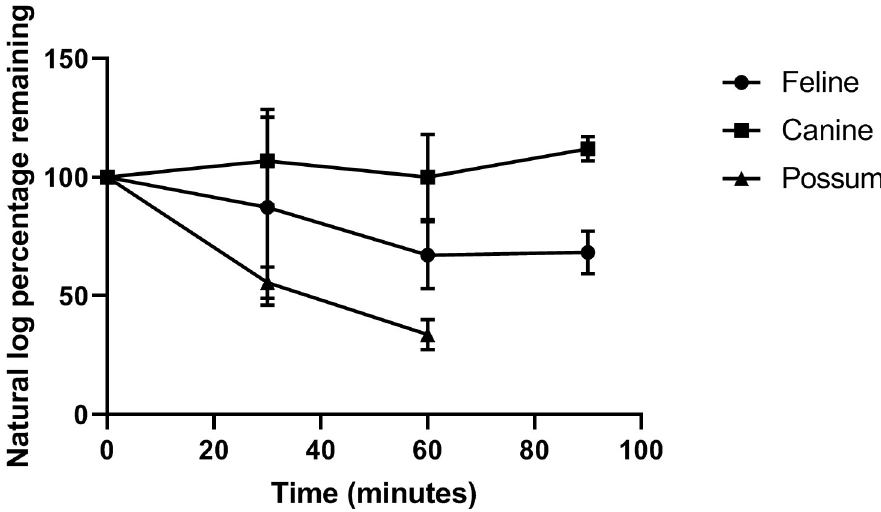
Fig 2. Mefloquine depletion concentration (expressed as log substrate remaining) as a percentage vs. incubation time between species. Microsome concentrations of 1.0 mg/mL for all species were incubated with 10 μ M final concentrations of mefloquine. Duplicate samples were run for each time point for each species. The error bars represent the standard error of the mean (SEM).